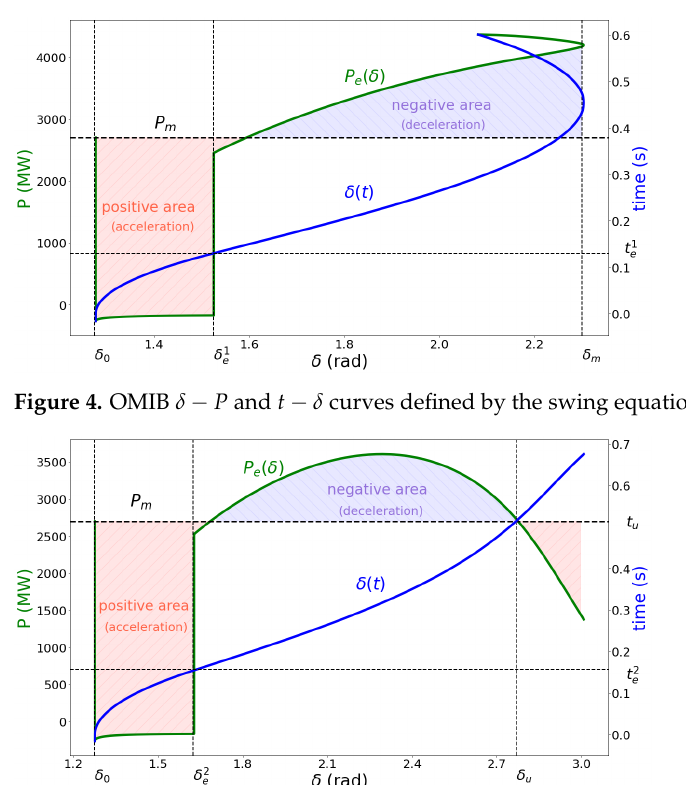
Figure 5. OMIB δ − P and t − δ curves defined by the swing equation for a first-swing unstable